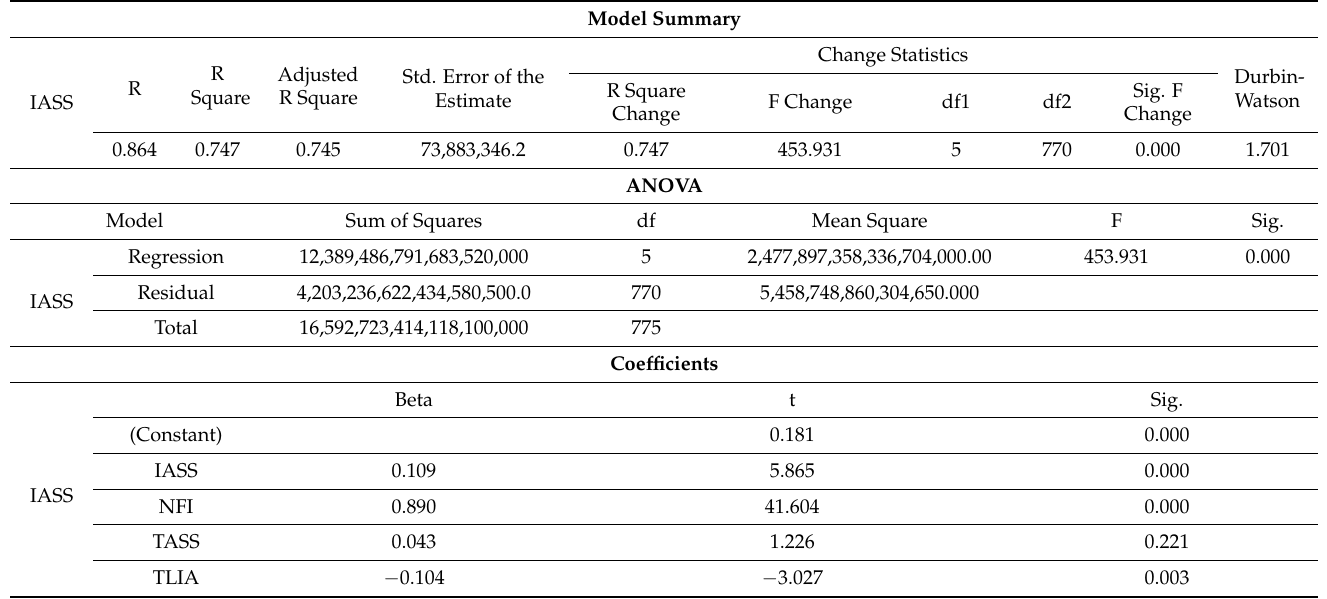
Table 12. Multiple regression analysis for factor